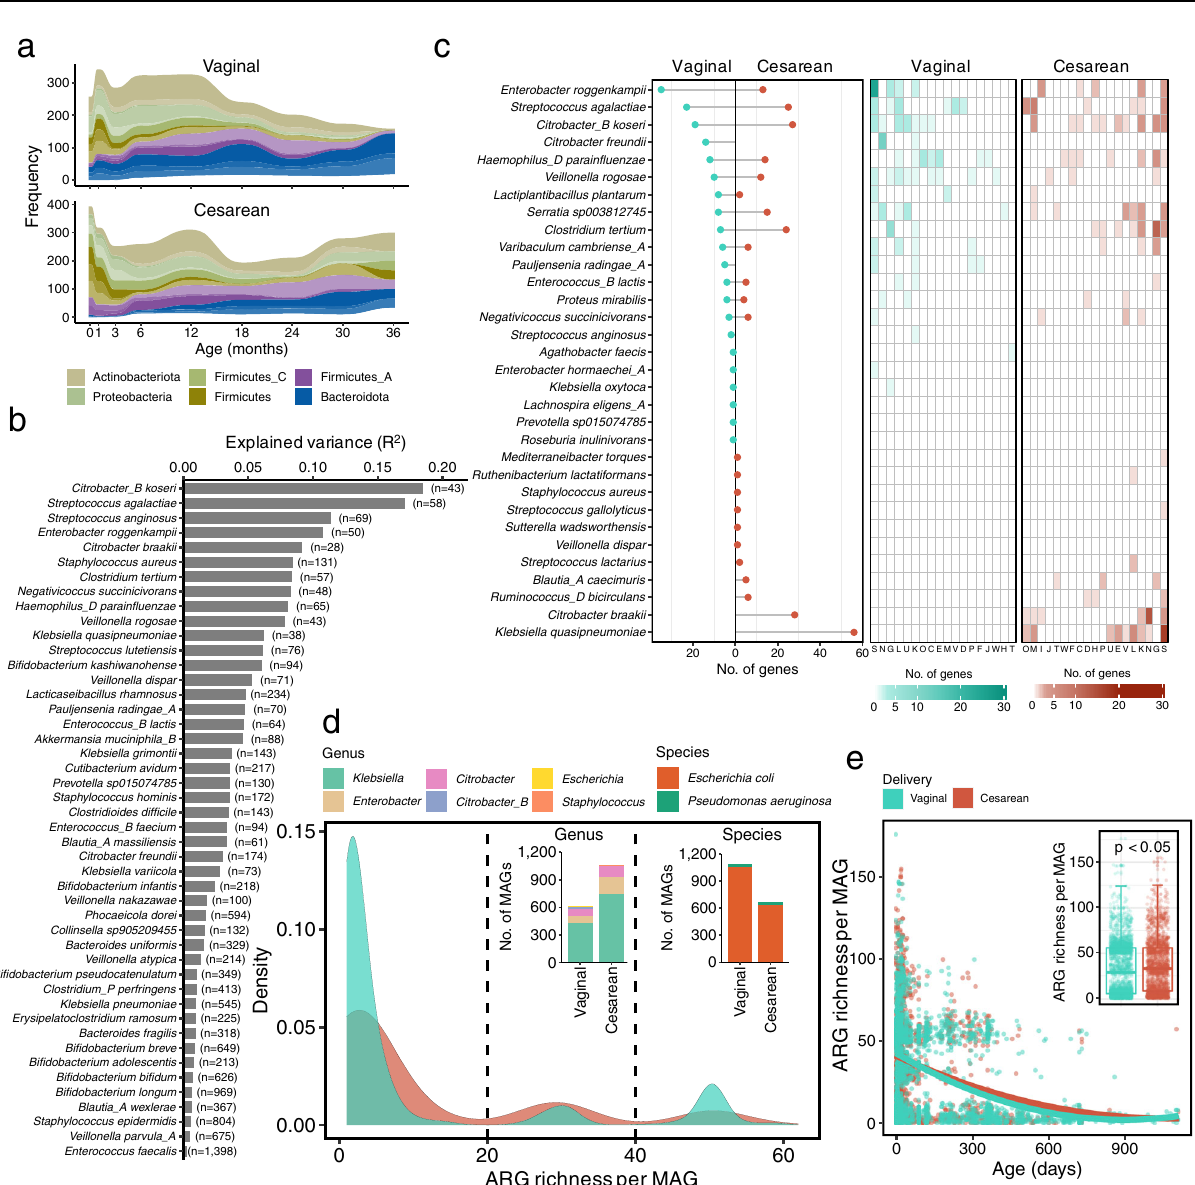
associated functions annotated by COGs database. d The density of antibiotic resistance genes (ARGs) richness in each genome of ELGG, and the taxonomic assignmentofthegenomesatgenus(leftinset)andspecies(rightinset)level. e The dynamics of ARGs richness from the early-life human gut microbiome in response totheageofchildren.ThegutmicrobiomefromchildrenbornbyC-sectioncarried higher (two-tailed Wilcoxon test, p <0.05, inset) number of ARGs than that of childrenbornvaginally.Theinsetboxesshowtheinterquartilerange(IQR),withthe horizonal line as the median, the whiskers indicating the range of the data (up to 1.5× IQR), and points beyond the whiskers as